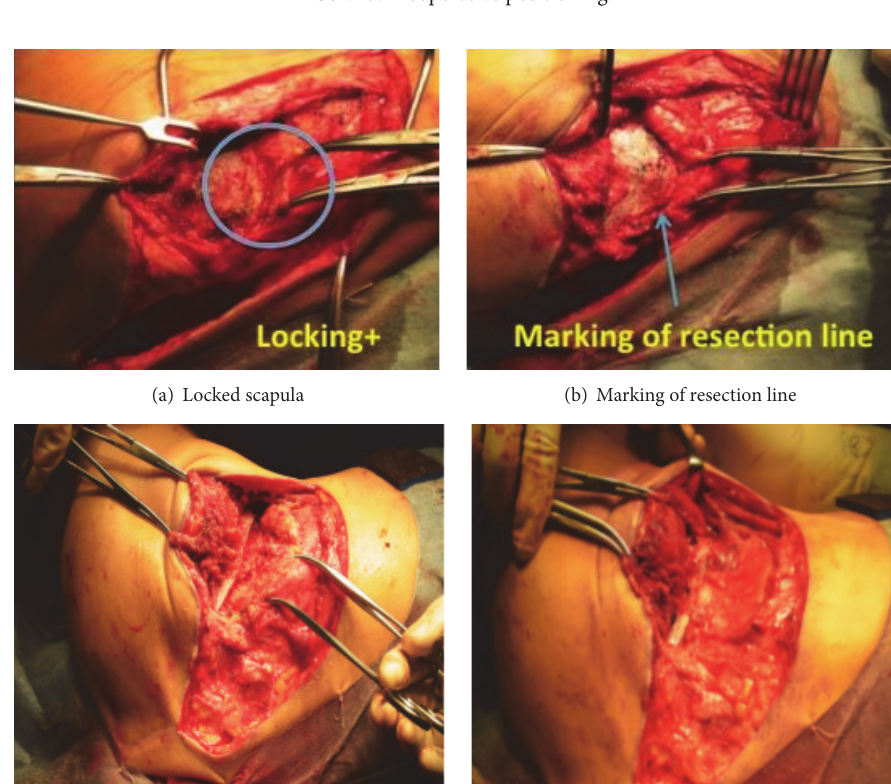
Figure 3: Preoperative positioning.